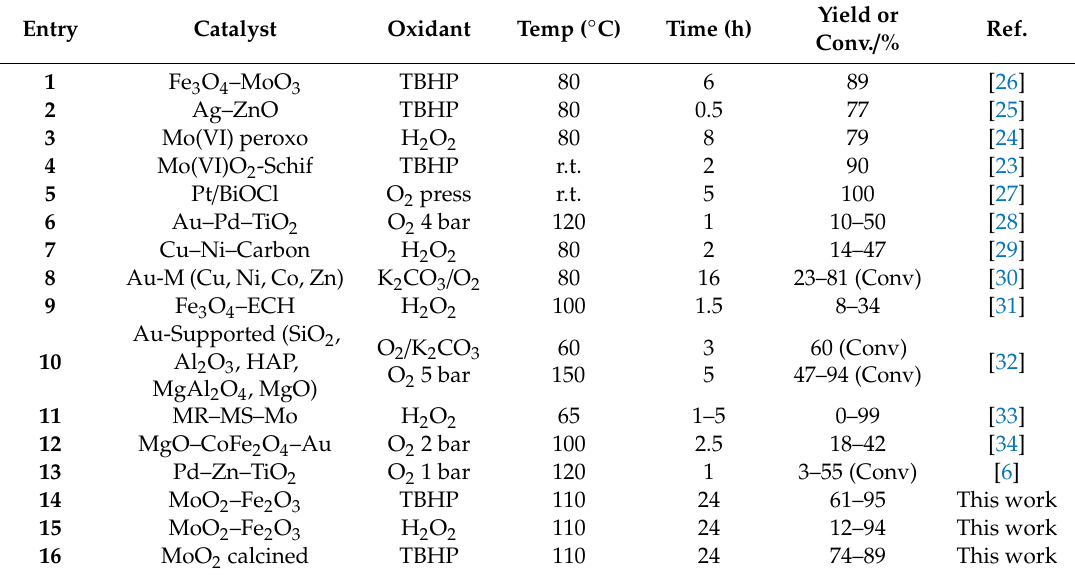
Table 4. Comparison of the catalytic performance of the MoO 2 NP catalysts described in this work with other systems reported in the